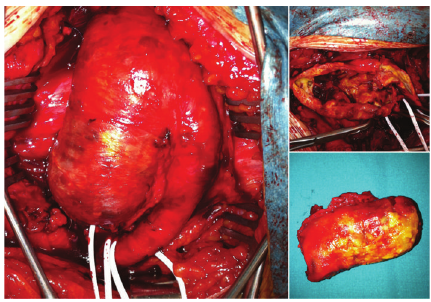
Figure 1: Intraoperative image of the true giant left profunda femoral artery aneurysm. On the right, the aneurysm is opened with a large thrombus.